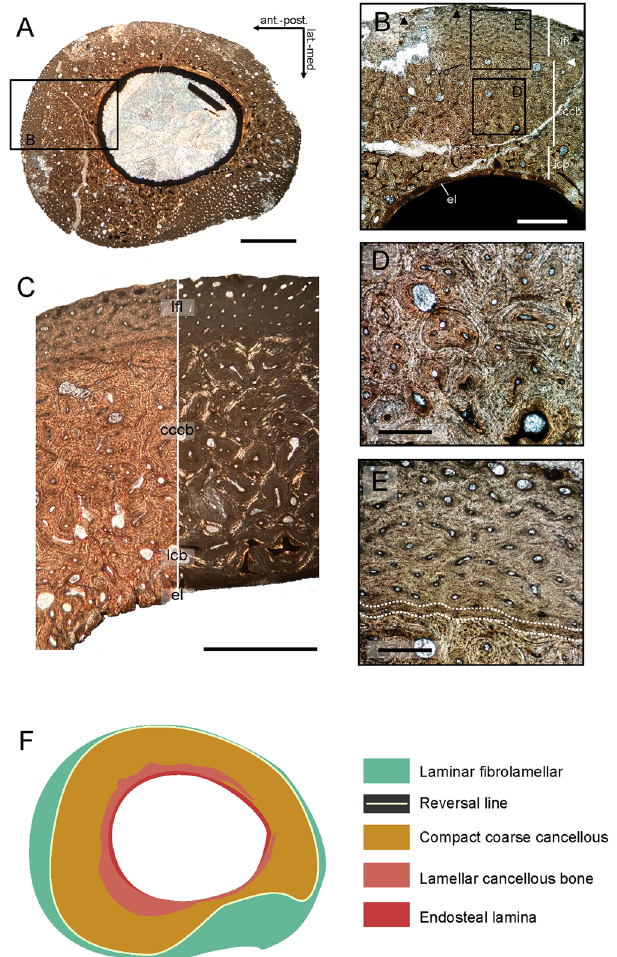
Figure 4. Osteohistology of Tamarro insperatus gen. et sp. nov. based on the osteohistological sample from the metatarsal II (MCD-7073). Full petrographic transverse thin section from the proximal mid-shaft of the Mt II ( A ). Detail of the cortex showing the predominance of primary lamellar and fibrolamellar bone tissues. Black arrows indicate the location of a LAG. White arrow shows the location of the reversal line ( B ). Outer cortex under transferred and polarized light displaying the distinctive arrangement of the bone tissues ( C ). Magnification of the inner cortex showing the infilling of primary cancellous spaces with lamellar bone ( D ). Osteohistological transition (white dashed lines) between the compact coarse cancellous bone of the inner cortex and the laminar fibrolamellar of the outer cortex ( E ). Type tissue map of areas representing different tissue types are colour coded for quantitative analyses ( F ). cccb compact coarse cancellous bone; el endosteal lamina; lcb lamellar cancellous bone; lfl laminar fibrolamellar; pvc primary vascular canal. Scale bar: 2 cm ( A ), 0.5 mm ( B ), 1 cm ( C ), and 0.2 mm ( D , E